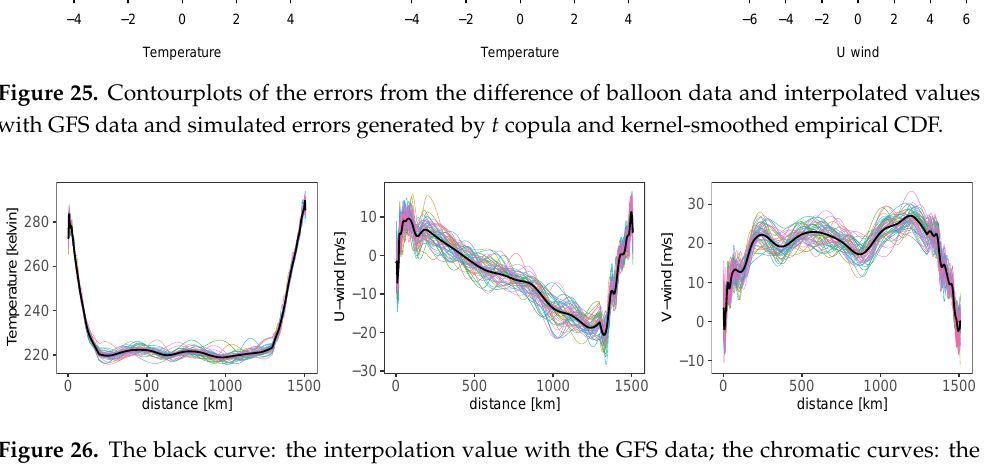
Figure 26. The black curve: the interpolation value with the GFS data; the chromatic curves: the interpolated values with simulated weather